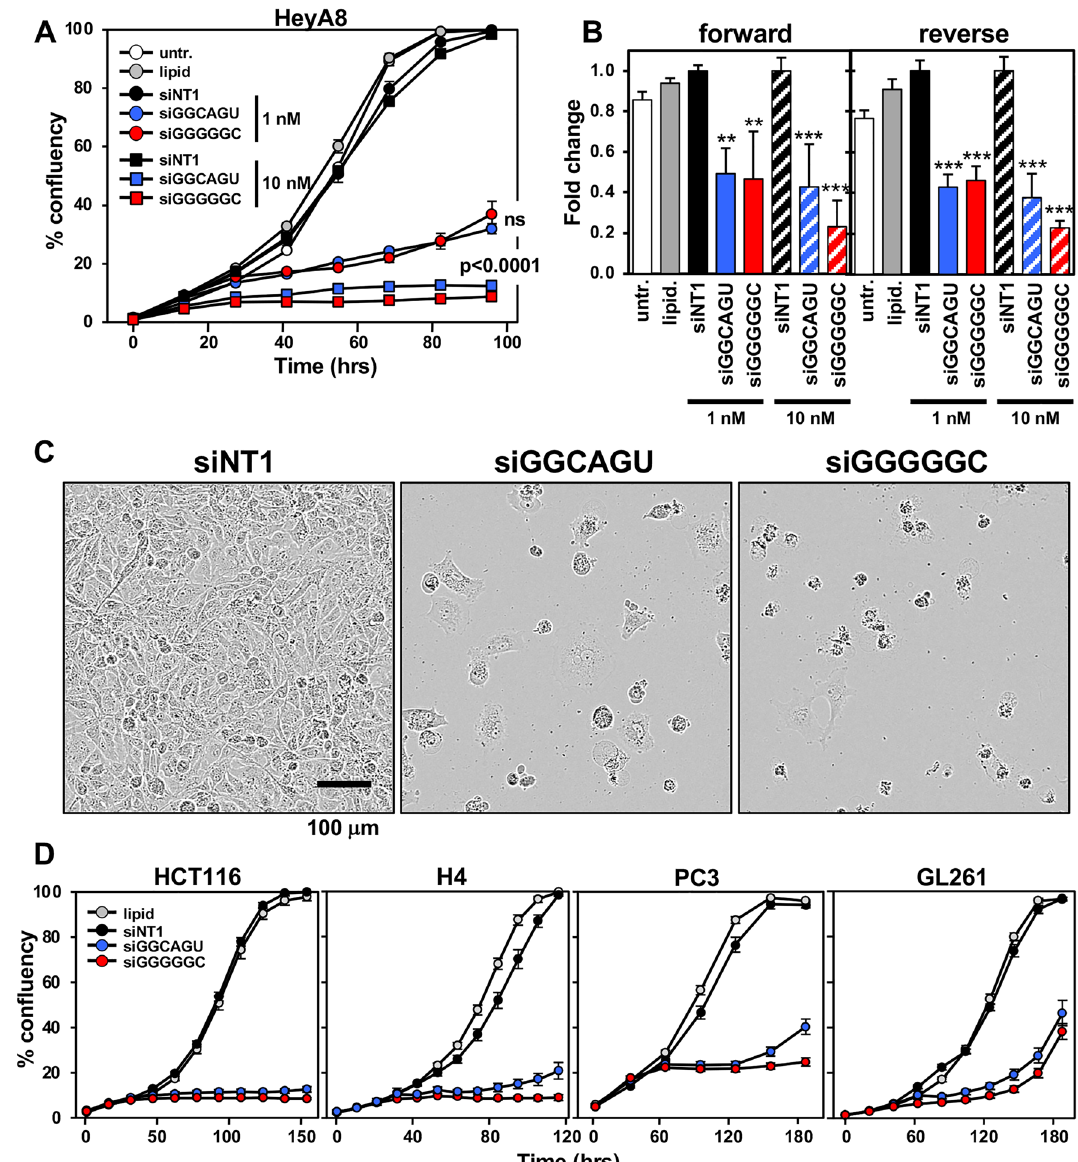
Figure 2. Both siGGC AGU and siGGG GGC are toxic to cancer cells. ( A ) Change in confluence (growth) over time of HeyA8 cells reverse transfected with either 1 or 10 nM of siNT1, siGGC AGU , or siGGG GGC . ANOVA p-values between the two toxic siRNAs are shown. ns not significant. Each data point represents mean ± SE of six replicates. ( B ) Percent viability (ATP content) 96 h after transfecting HeyA8 cells (forward or reverse) with 1 or 10 nM of the indicated siRNAs, or with lipid only or left untreated. Experiment was done in 6 replicates. ***p < 0.0001, **p < 0.001. ( C ) Phase contrast images showing morphology of HeyA8 cells reverse transfected in A at 10 nM 4 days post transfection. ( D ) Change in confluence over time of HCT116 (human colon cancer) and H4 (human neuroglioma), PC3 (human prostate cancer), or GL261 (mouse glioma) cells reverse transfected with 10 nM (HCT116, H4, and PC3) or 25 nM (GL261) of siNT1, siGGC AGU , or siGGG GGC . Each data point represents mean ± SE of six or four replicates, respectively. In all three cases the optimal amount of transfection reagent (lipid) was used to avoid non-specific growth